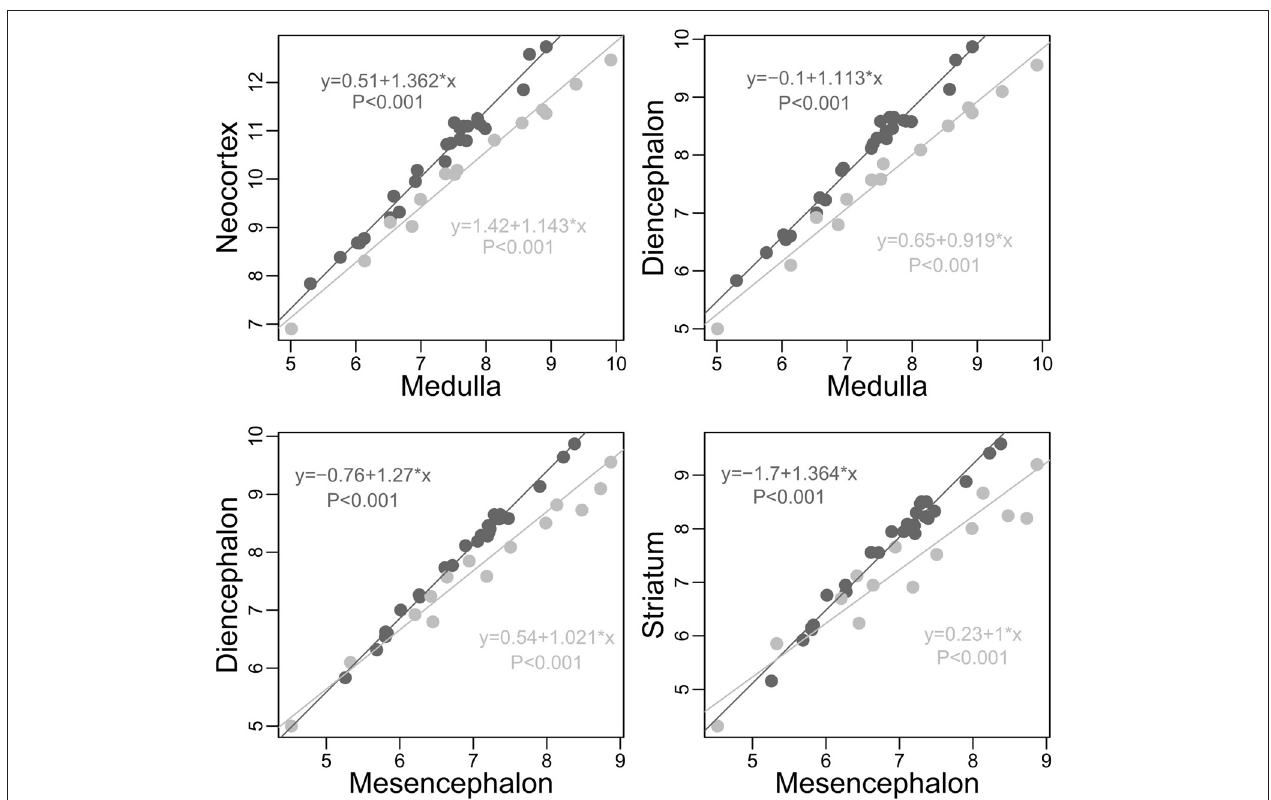
FIGURE 3 | Plots of some of the most obvious differences between carnivores (light gray) and simians (dark gray, human species excluded) cerebrotypes (log scale). On average (although an average is inappropriate due to slope differences), for similar medulla sizes, simians possess a neocortex and a diencephalon 2 times larger than carnivores (neocortex: Minimum 1.323, 1st Quartile 1.506, Median 2.007, Mean 2.047, 3rd Quartile 2.322, Maximum 3.509; diencephalon: Min. 1.362, 1st Qu. 1.611, Median 2.001,